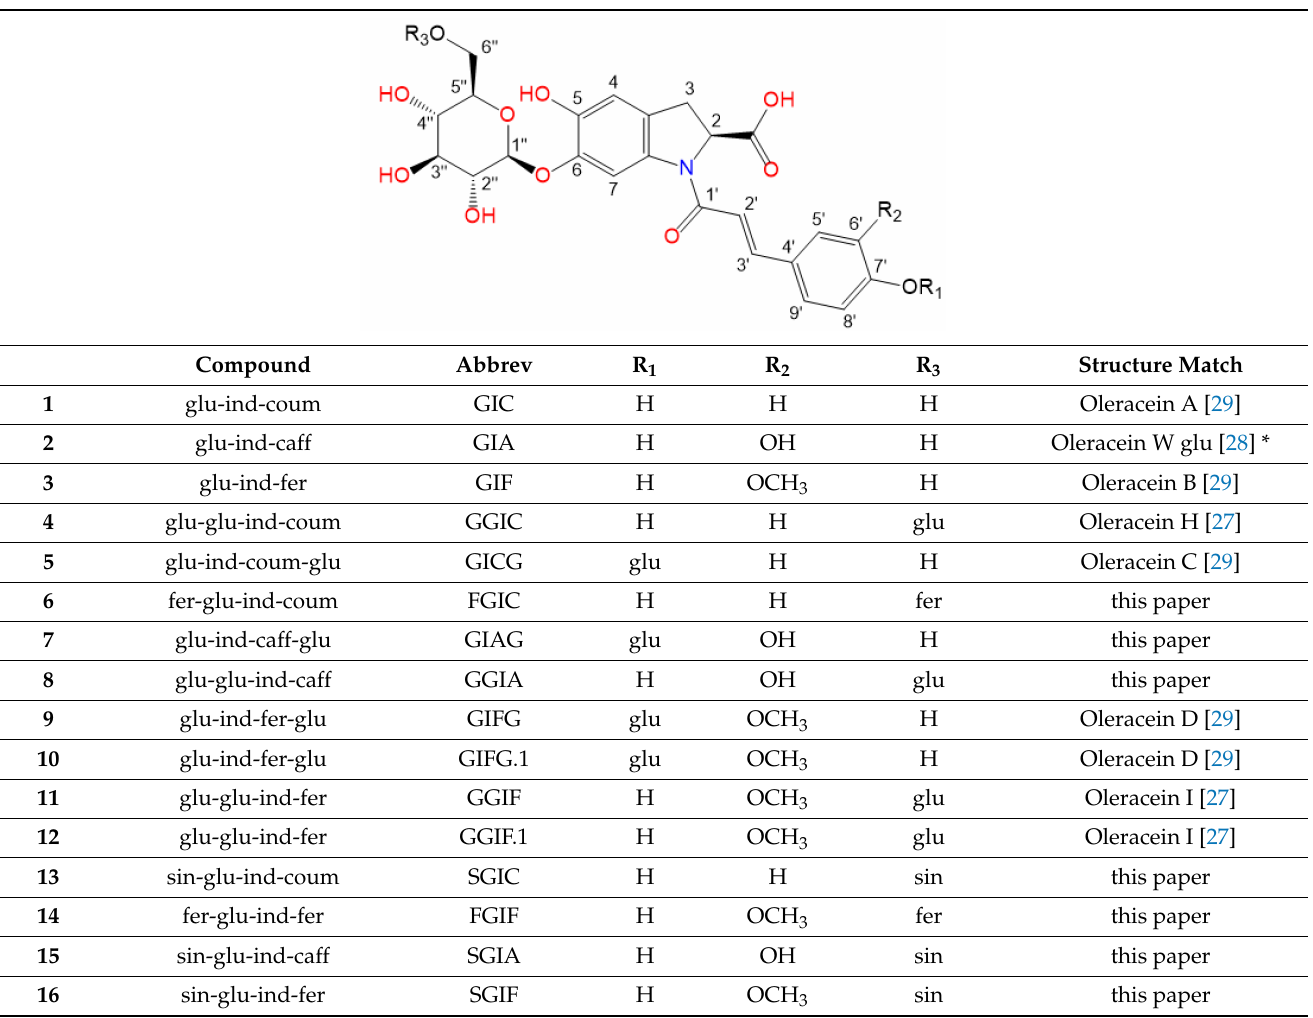
Table 2. Structure representation of the identified 51 oleraceins. For a list of used abbreviations, see “4.9. Used